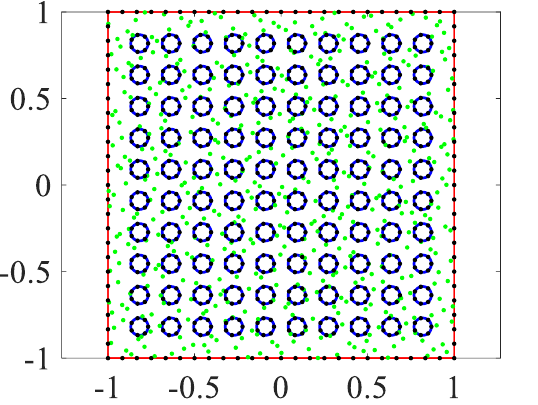
Figure 3. Computational domain with node distributions of the traditional RBFCM (boundary nodes “ ● ” , interior nodes “ ● ” ).